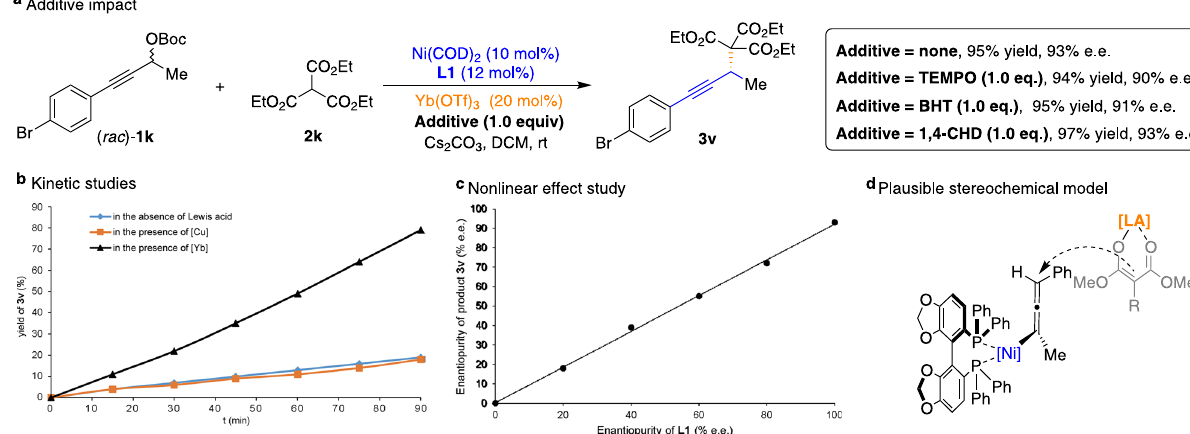
Fig. 5 Mechanistic studies. a Radical scavenger experiments. b Kinetic studies. The dependence of the reaction rate by varying the Lewis acid additives. c Nonlinear relationship between the optical activity of phosphine ligand L1 and propargylated adduct 3v . d Plausible stereochemical model. TEMPO 2,2,6,6-tetramethylpiperidinyloxy, BHT butylated hydroxytoluene,